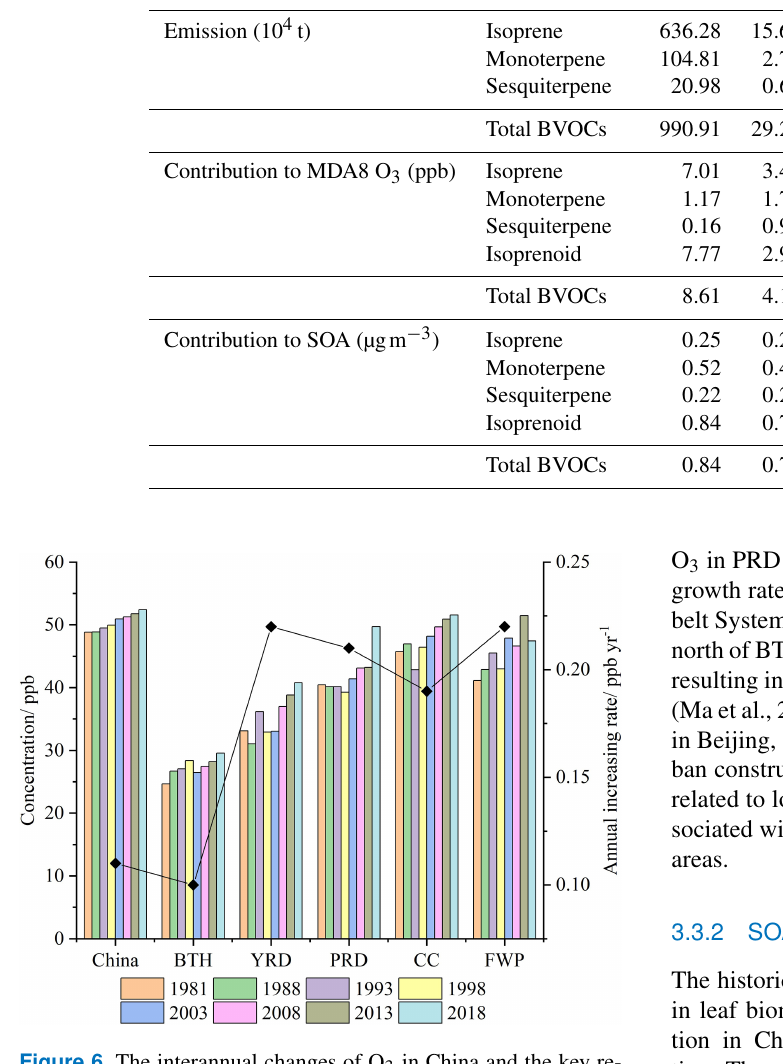
Figure 6. The interannual changes of O 3 in China and the key re-